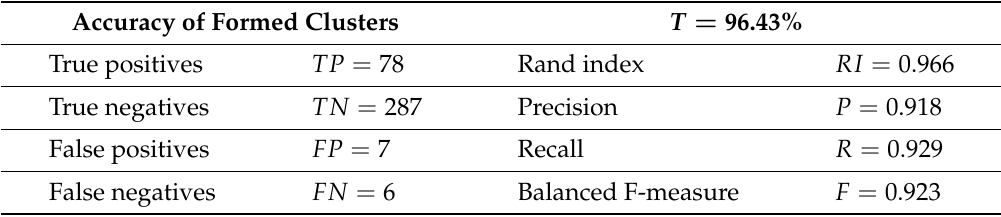
Table 7. Evaluation of clustering results obtained by IBC2 algorithm using RealWorld data set.